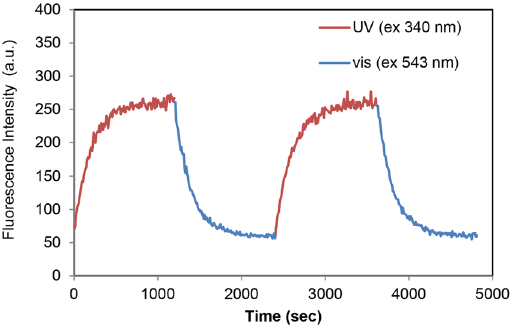
Figure 4. UV dependent photoswitching of N -nitroBIPS-DPPG fluorescence. The fluorescence ( λ ex = 543 nm, λ em = 600 nm) of a DOPC/ N -nitroBIPS-DPPG (9:1) dispersion (50 μ M) was recorded during alternating (5 sec intervals) UV (340 nm) and green light (543 nm) exposure (red line) and during continuous green light (543 nm) irradiation (blue line). Repeated photoswitching cycles did not reveal significant photobleaching of N - nitroBIPS-DPPG fluorescence. Representative data of three independent experiments.